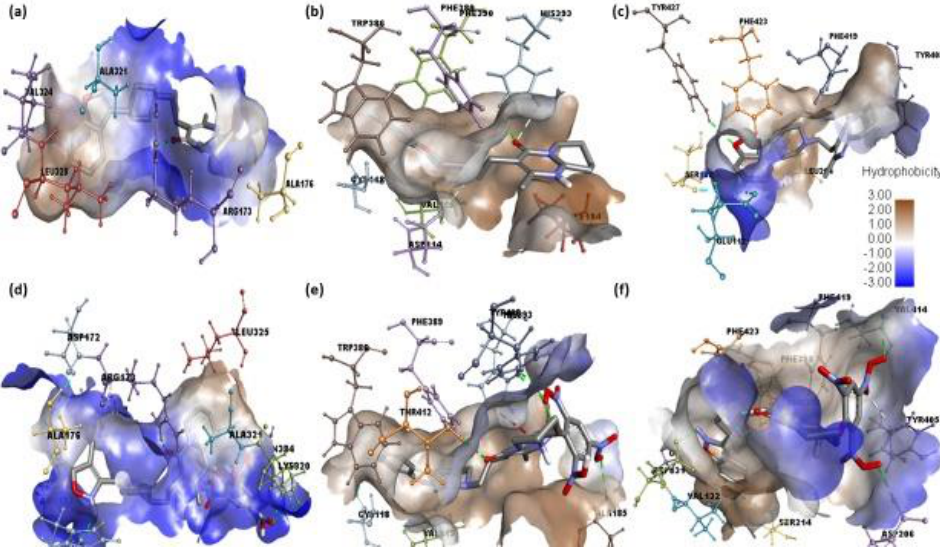
Figure 9. Representations of hydrophobic binding surfaces of serotonin, dopamine, and adrenergic receptors docked with ( a – c ) risperidone and ( d – f ) CTcS complex.